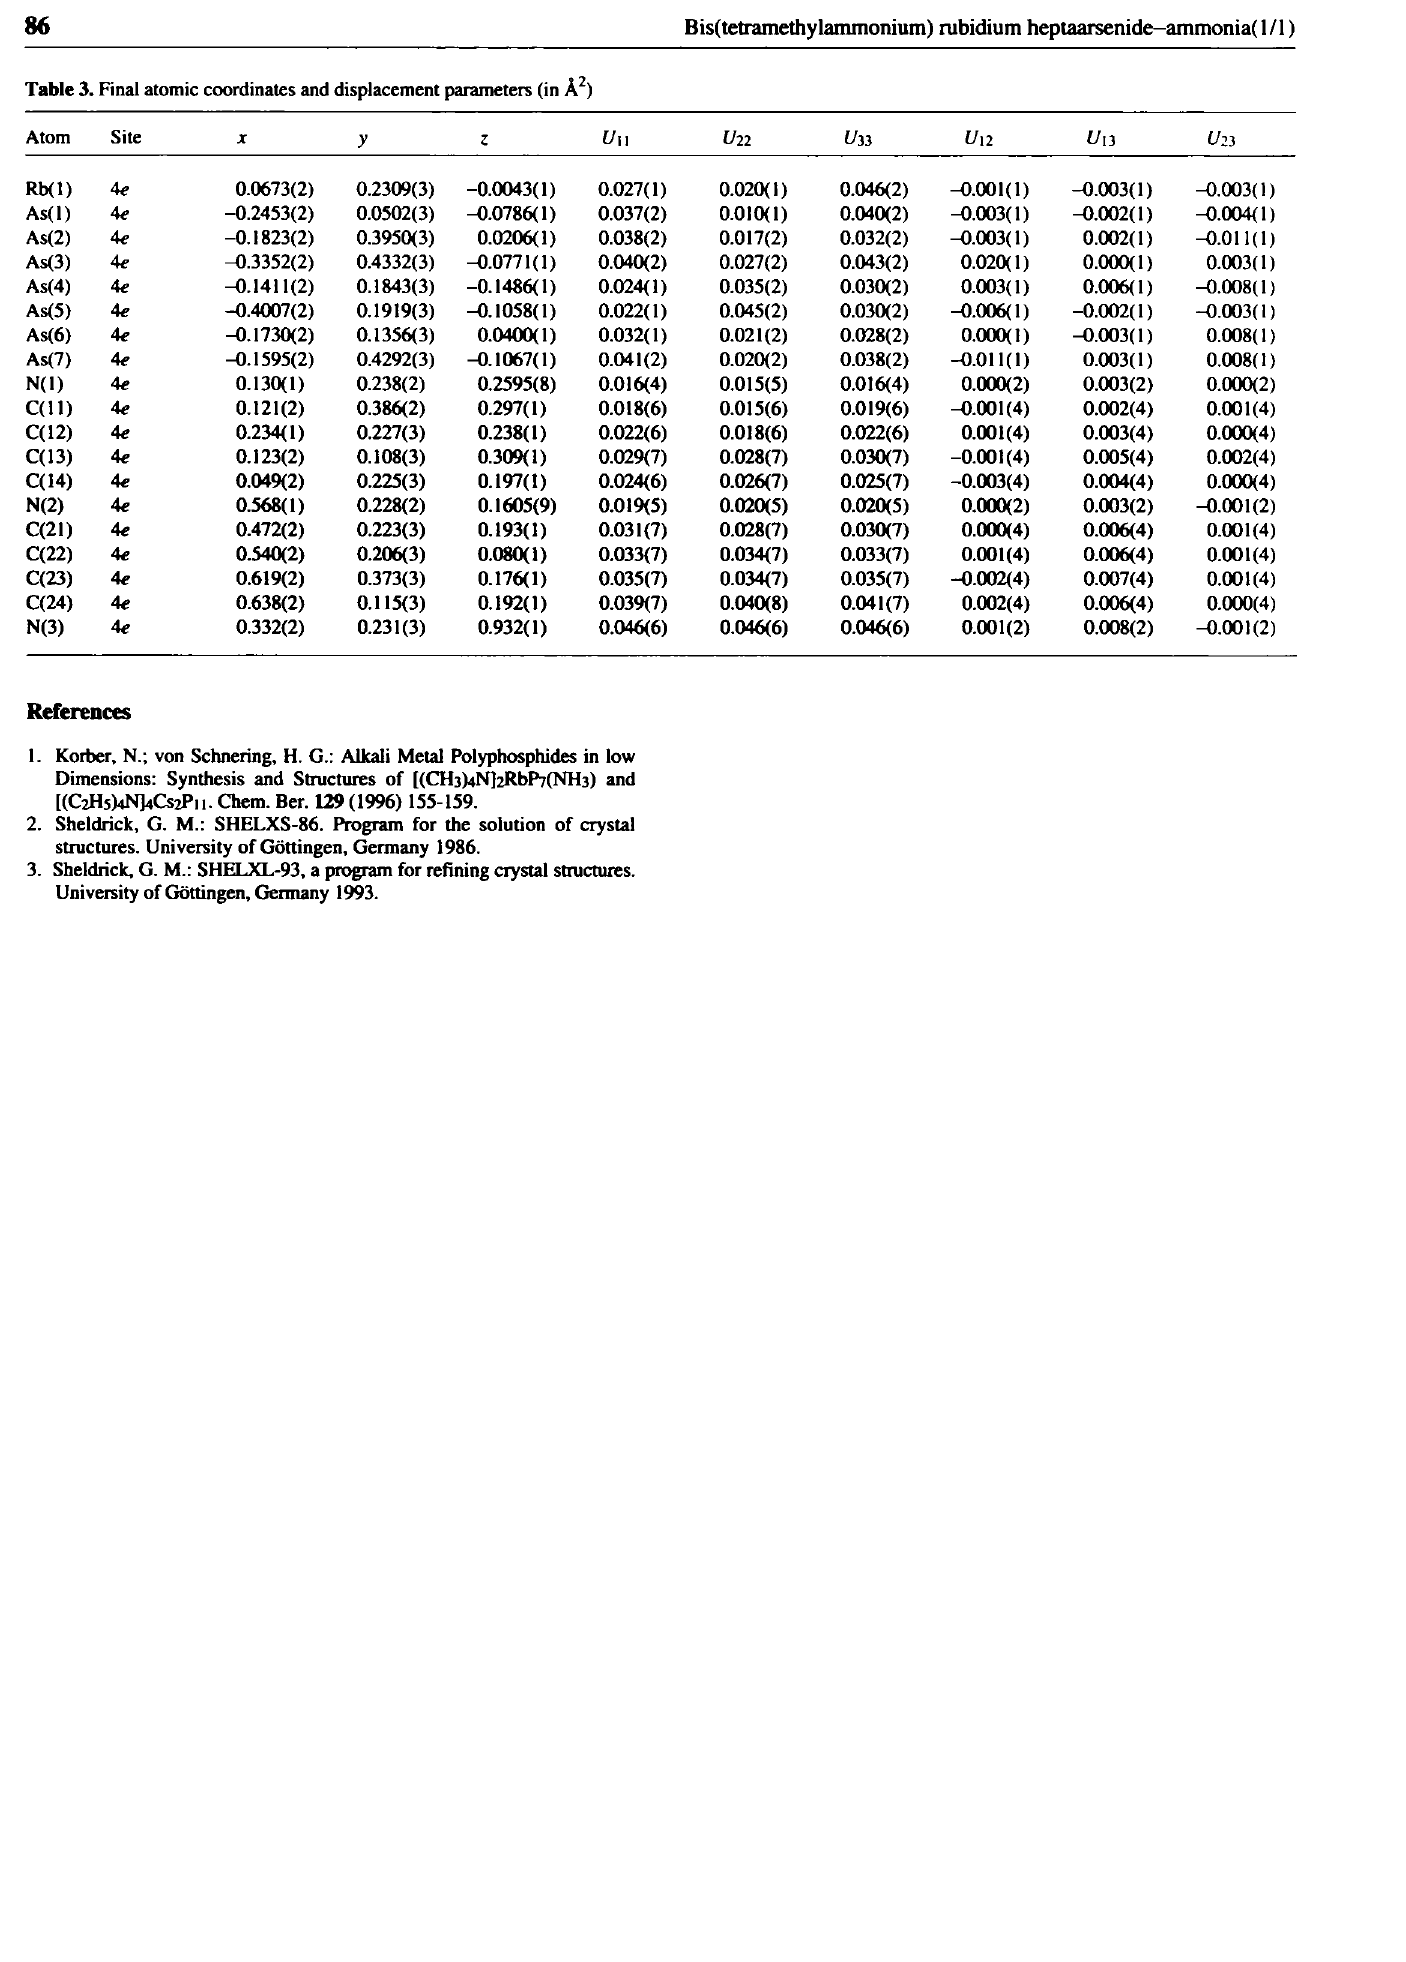
Table 3. Final atomic coordinates and displacement parameters (in Â 2 )